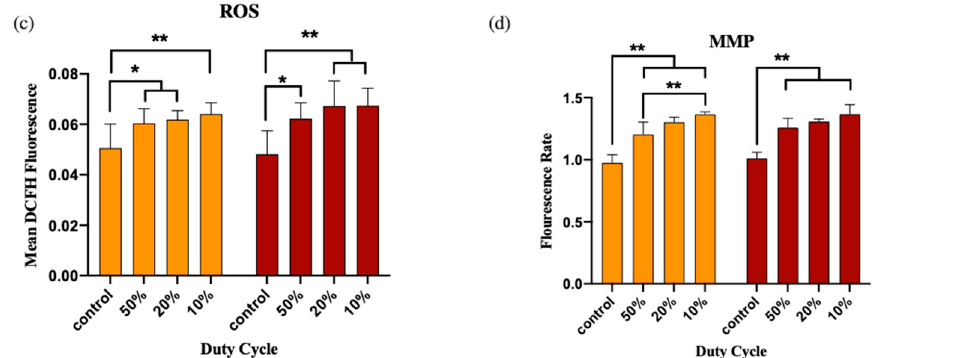
Figure 7. Comparison between control and PW light with different duty cycles: ( a ) cell viability, ( b ) ATP, ( c ) ROS, and ( d ) MMP. * p < 0.05 and ** p < 0.01.